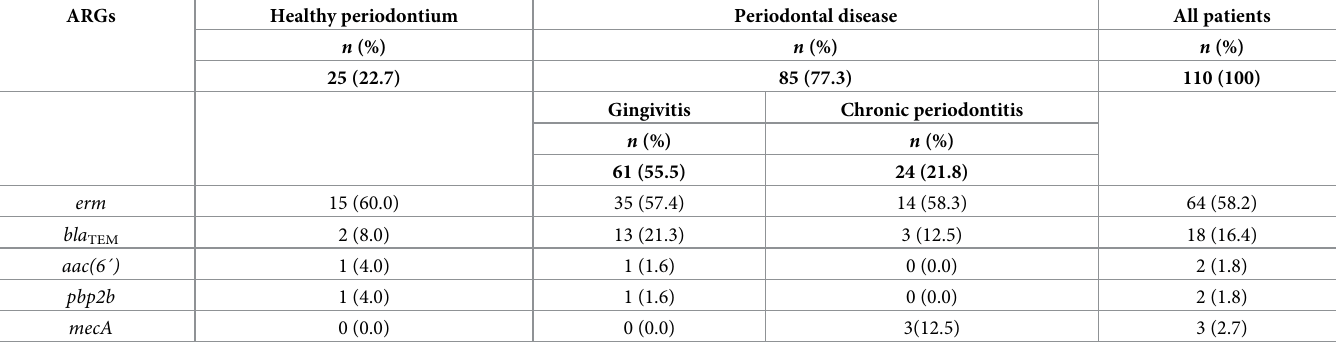
Table 2. Prevalence of Antibiotic Resistance Genes (ARGs) stratified by periodontal health status ( n = 110).